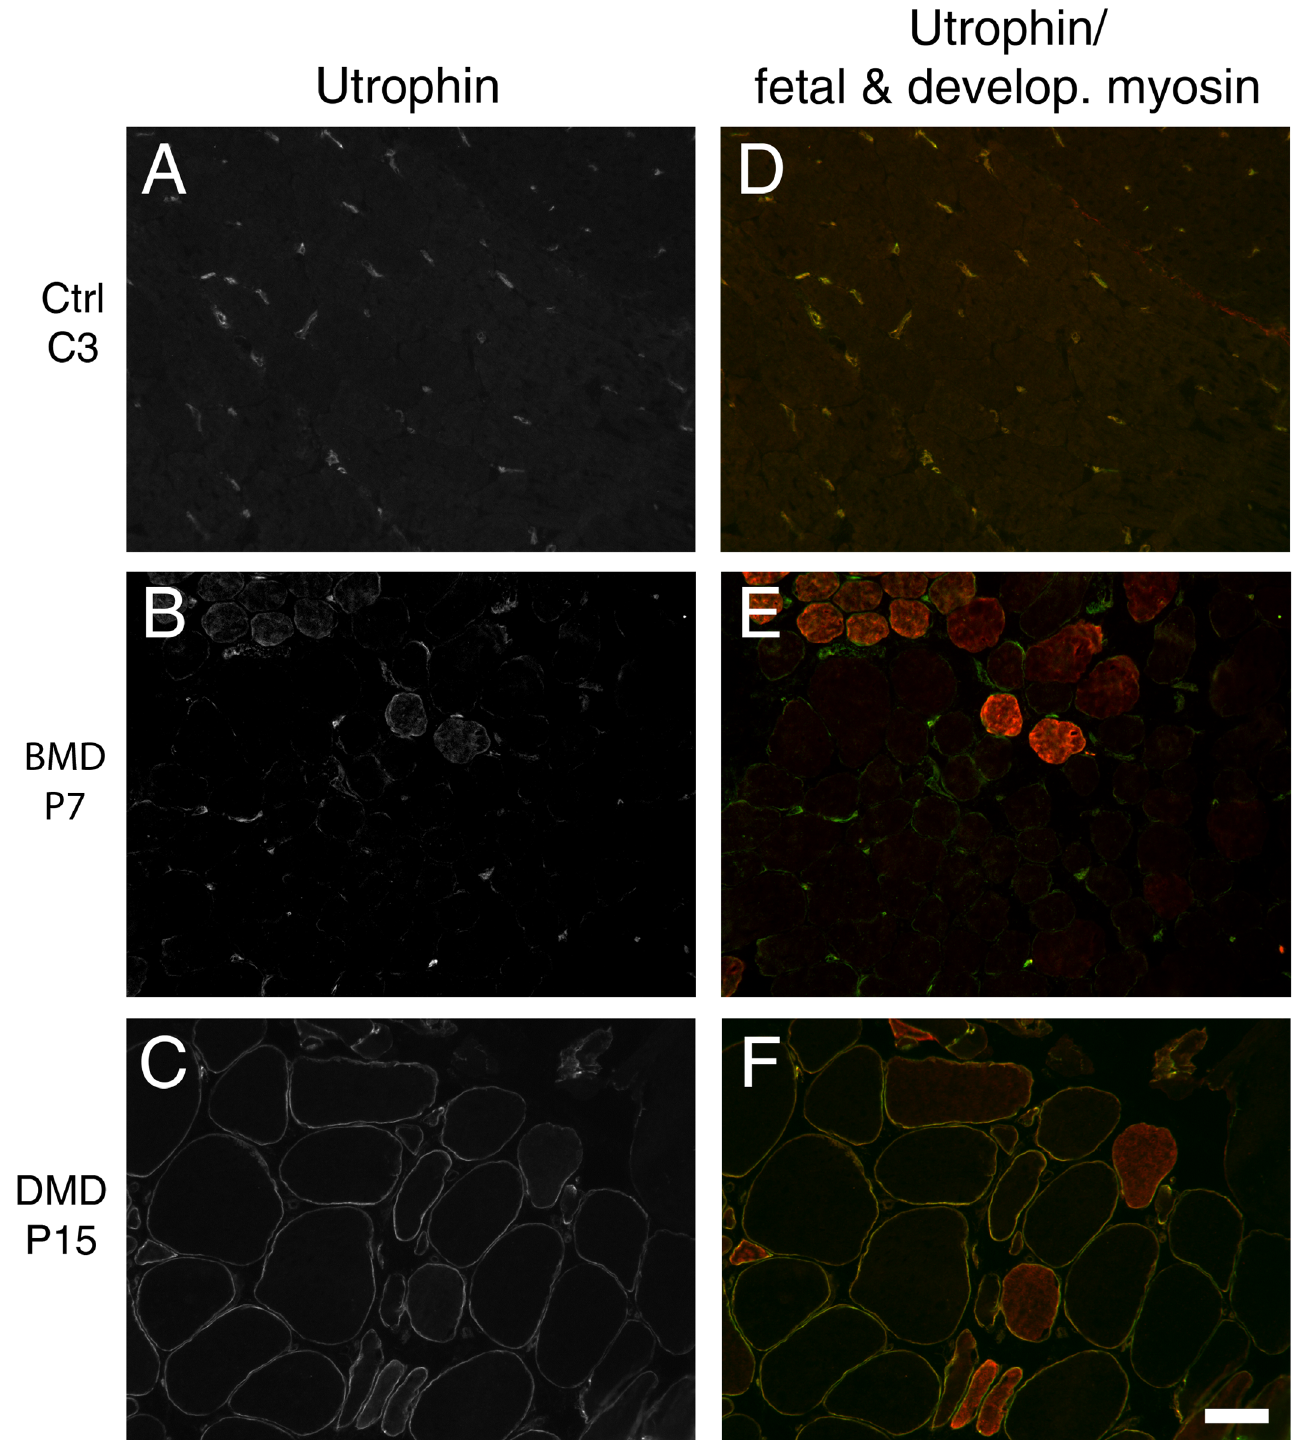
Fig 1. Co-immunostaining of muscle sections with utrophin and fetal and developmental myosin antibodies. (A-C) No sarcolemmal utrophin staining in control (C3), weak labelling in BMD (P7) and strong labelling in DMD (P15) muscle sections used for intensity analysis. (D-F) Utrophin merged with fetal and developmental (develop.) myosin staining to identify regenerating fibres, which were excluded from the analysis in this experiment. White bar — 50 μ M.